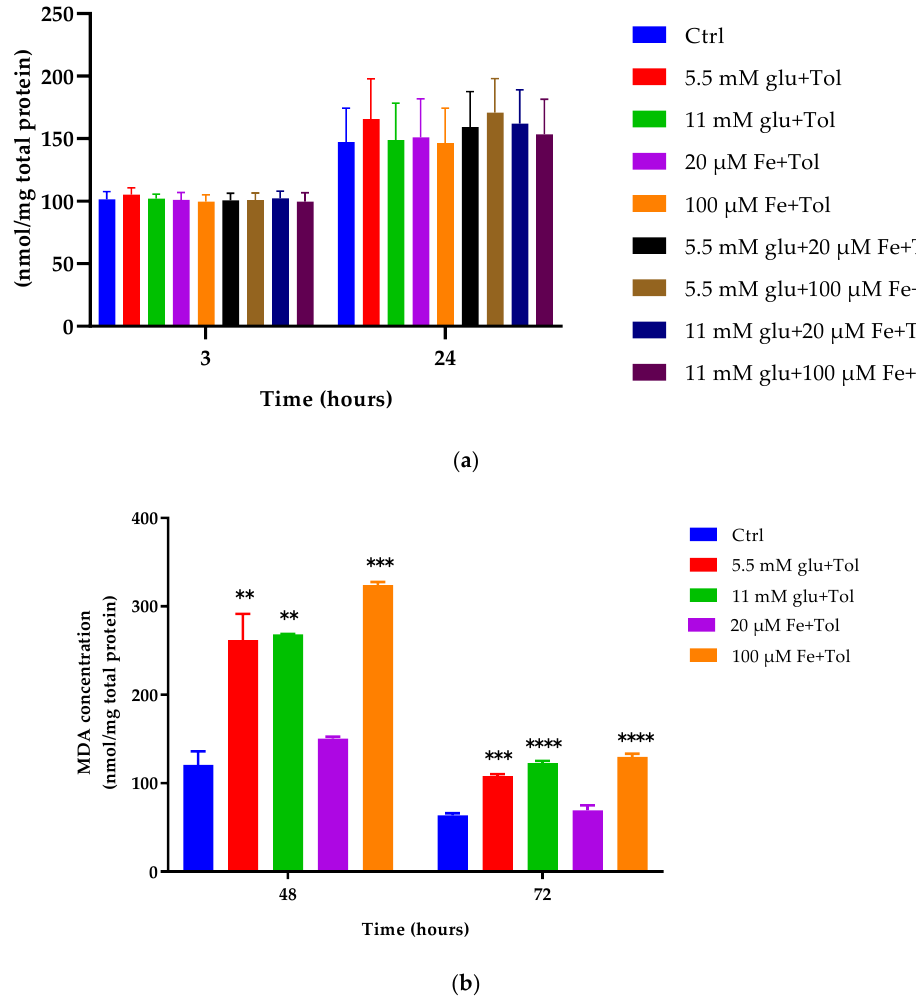
Figure 4. Determination of lipid peroxidation marker (MDA) performed by TBARS assay ( a ) following 3 h and 24 h incubation with test conditions; iron (20 µ M and 100 µ M) and/or glucose (5.5 mM and 11 mM), and combinations of iron and glucose and ( b ) following 48 h and 72 h incubation with these test conditions (b). High iron and glucose (100 µ M and 11 mM respectively) in presence of tolbutamide as a secretagogue increased the concentration of MDA compared to control both at 48 and 72 h time points. The data represent mean ± SEM; n = 4. ** p < 0.0012 (5.5 mM glu—48 h), ** p < 0.001 (11 mM glu—48 h), *** p < 0.0002 (100 µ M Fe—48 h), *** p < 0.0003 (5.5 mM glu—72 h), **** p < 0.0001 (11 mM glu and 100 µ M Fe—72